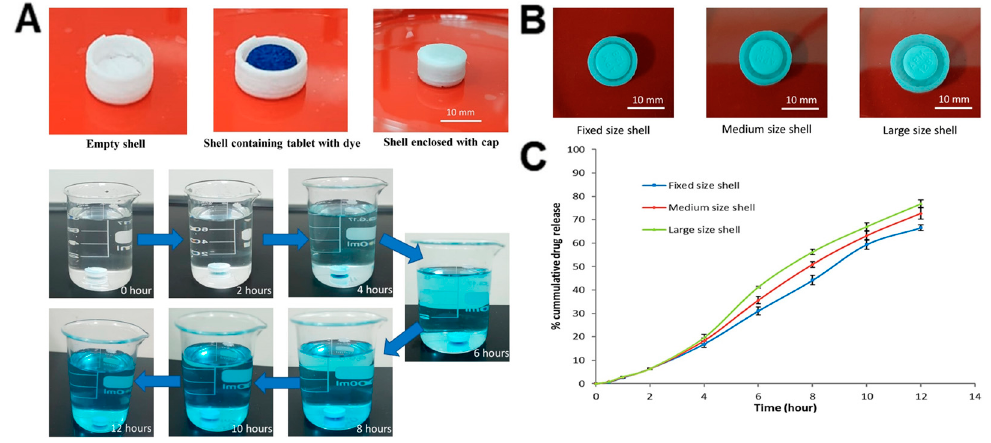
Figure 7. ( A ) Encapsulation of the propranolol HCl tablet soaked with color dye (methylene blue) inside the 3D printed controlled-release shell, and gradual increase of the intensity of the color solution showing visually the release of methylene blue from the 3D printed shell. ( B ) Different sizes of 3D printed controlled-release shells illustrating the gap/space between the enclosed tablet and the shell wall. ( C ) Cumulative release of propranolol HCl with phosphate buffer (pH 6.8) as dissolution media at temperature 37 ± 0.5 °C from 3D printed controlled-release shells of different sizes. Reprinted from [102], Polymers 2020.